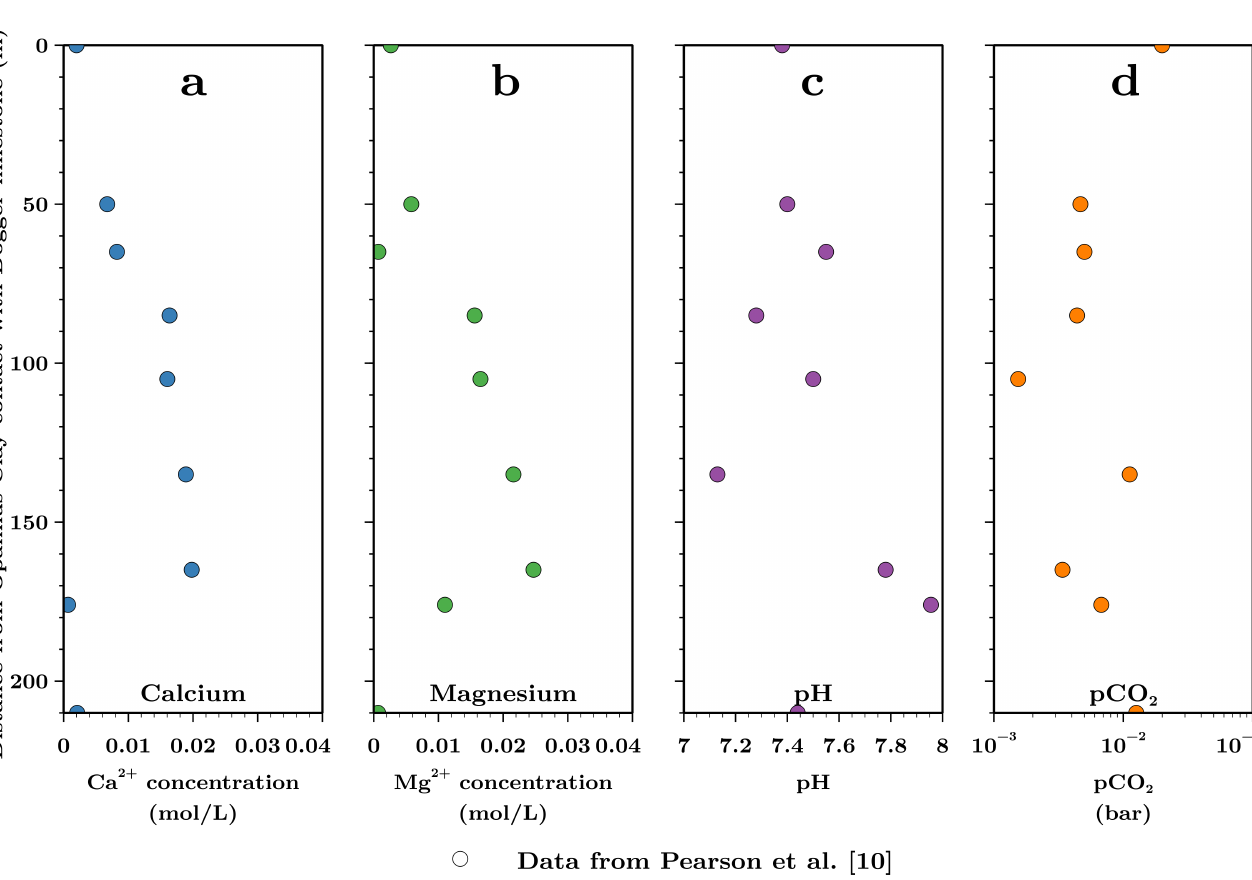
Figure 3. Concentration profiles of calcium ( a ), magnesium ( b ), pH ( c ), and pCO 2 ( d ) as governing parameters of uranium speciation and migration. The data stems from borehole analysis at the underground laboratory Mont Terri. The y-axis is the distance perpendicular to the contact between Opalinus Clay and Dogger